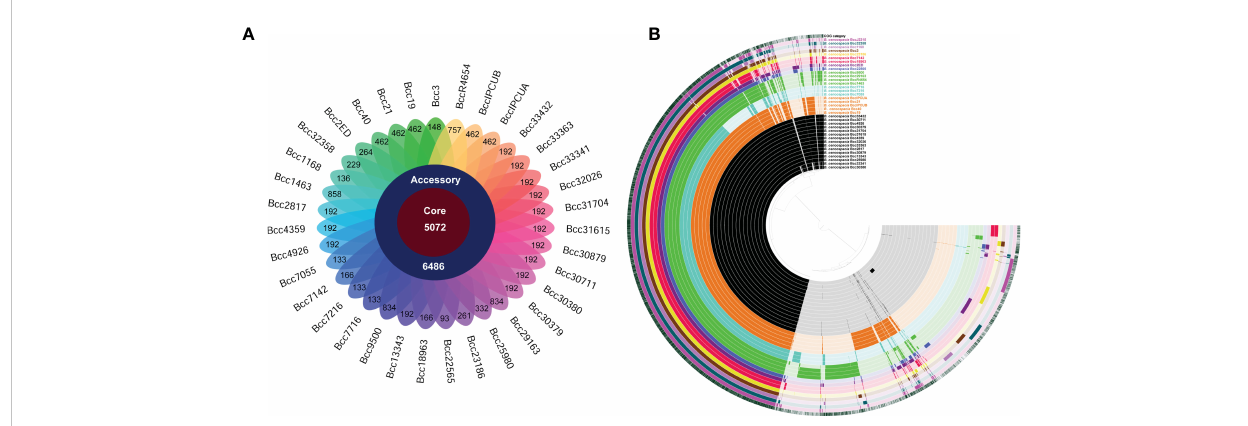
FIGURE 3 Distribution of gene cluster numbers in the pan-genome of CC31 isolates from India. (A) A fl ower plot schematic representation depicts the number of gene clusters (from inside to outside) in core, accessory, and unique genomes. (B) Comparative overview of pan- and core genomes obtained from the Anvi ’ o tool. The different B cenocepacia isolates grouped into sequence types (ST) are displayed (from inner to outer ring) by color black (ST839), orange (ST824), light blue (ST826), green (ST628), dark blue (ST208), purple (ST232), red (ST832), yellow (ST217), brown (ST841), light purple (ST822), and dark green (ST709). Last second ring represents reference B cenocepacia strain J2315. Last ring represents cluster of orthologous group categories. Each track indicates a genome, which is presented by number and color variations (dark/light), shows presence/absence of genes per genome.